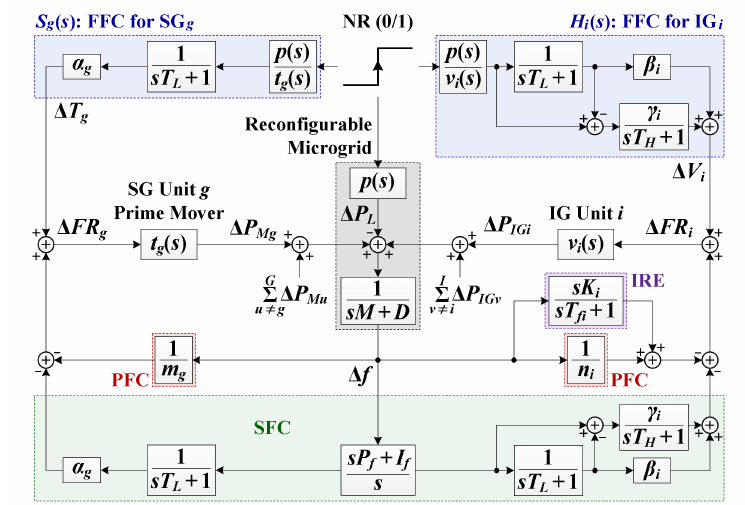
Figure 10. A small-signal model of an islanded reconfigurable MG with supplementary FFCs showing the feedback loops for the inertia response emulation and primary and secondary frequency control.